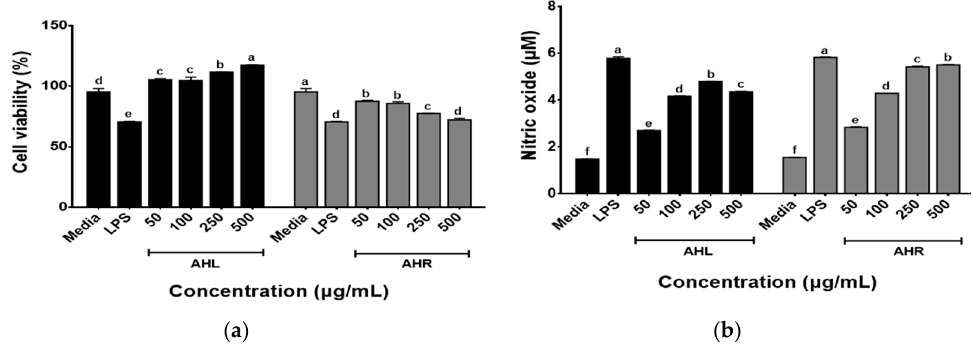
Figure 4. Effects of A. hookeri leaves (AHL) and A. hookeri roots (AHR) extracts on ( a ) the cell viability of and ( b ) the nitric oxide production by RAW 264.7 cells. The data was expressed as the mean ± SEM. a–h Different letters on bars are significantly different at p < 0.05. a–f Different letters on bars are significantly different at p <